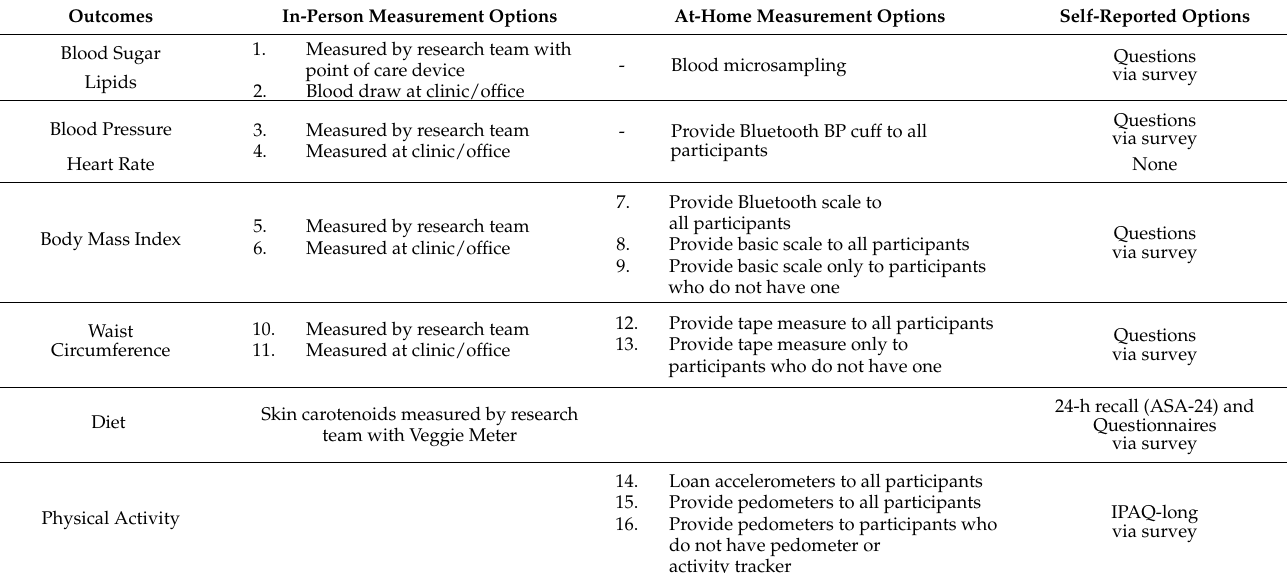
Table 1. Methods of data collection via in-person and at-home measurements, and self-reported